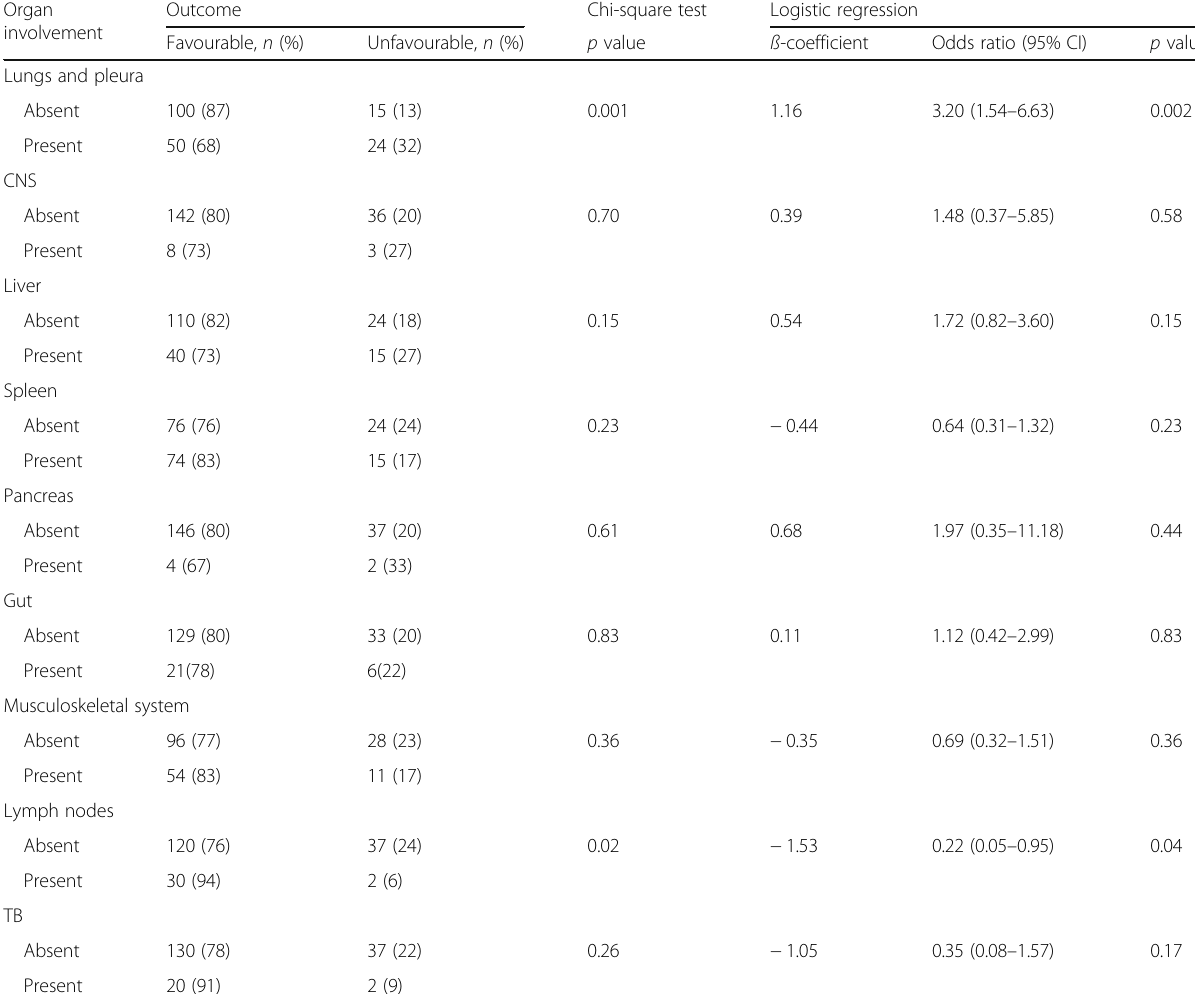
Table 2 Association of organ involvement with favourable/unfavourable outcome Organ Outcome Chi-square test Logistic involvement